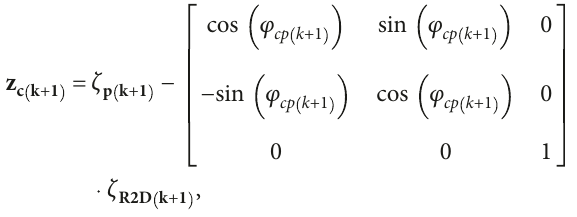
Figure 4: Top view of the landing